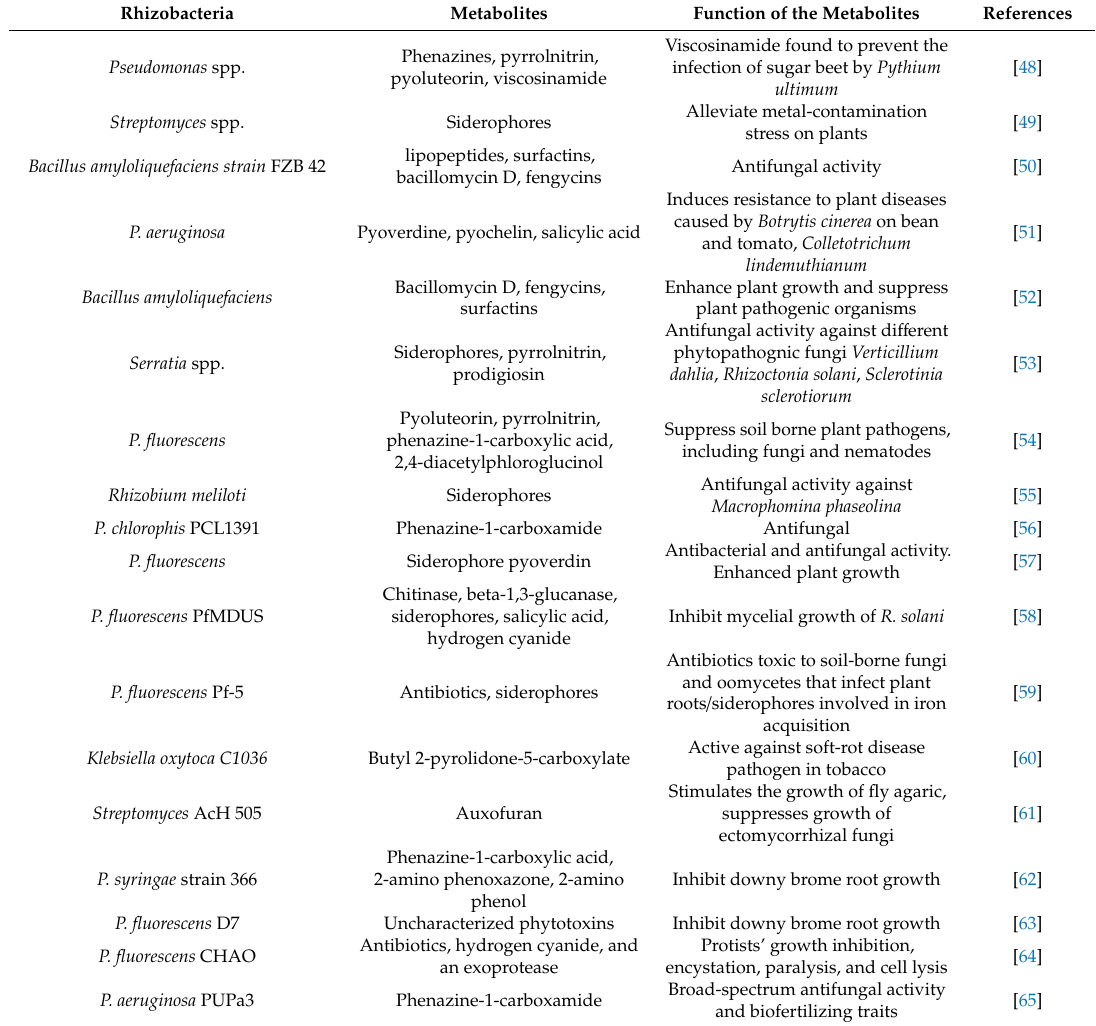
Table 2. Interactions of metabolites released by the rhizobacteria and their importance to plants.